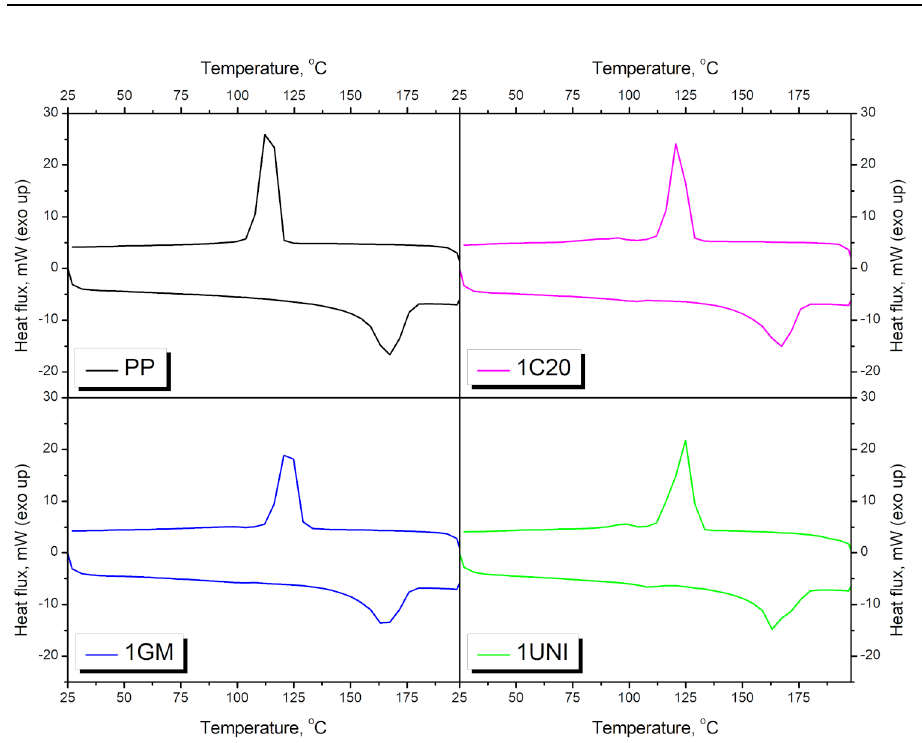
Figure 9. DSC thermograms for neat PP and PP modified with blowing agents.